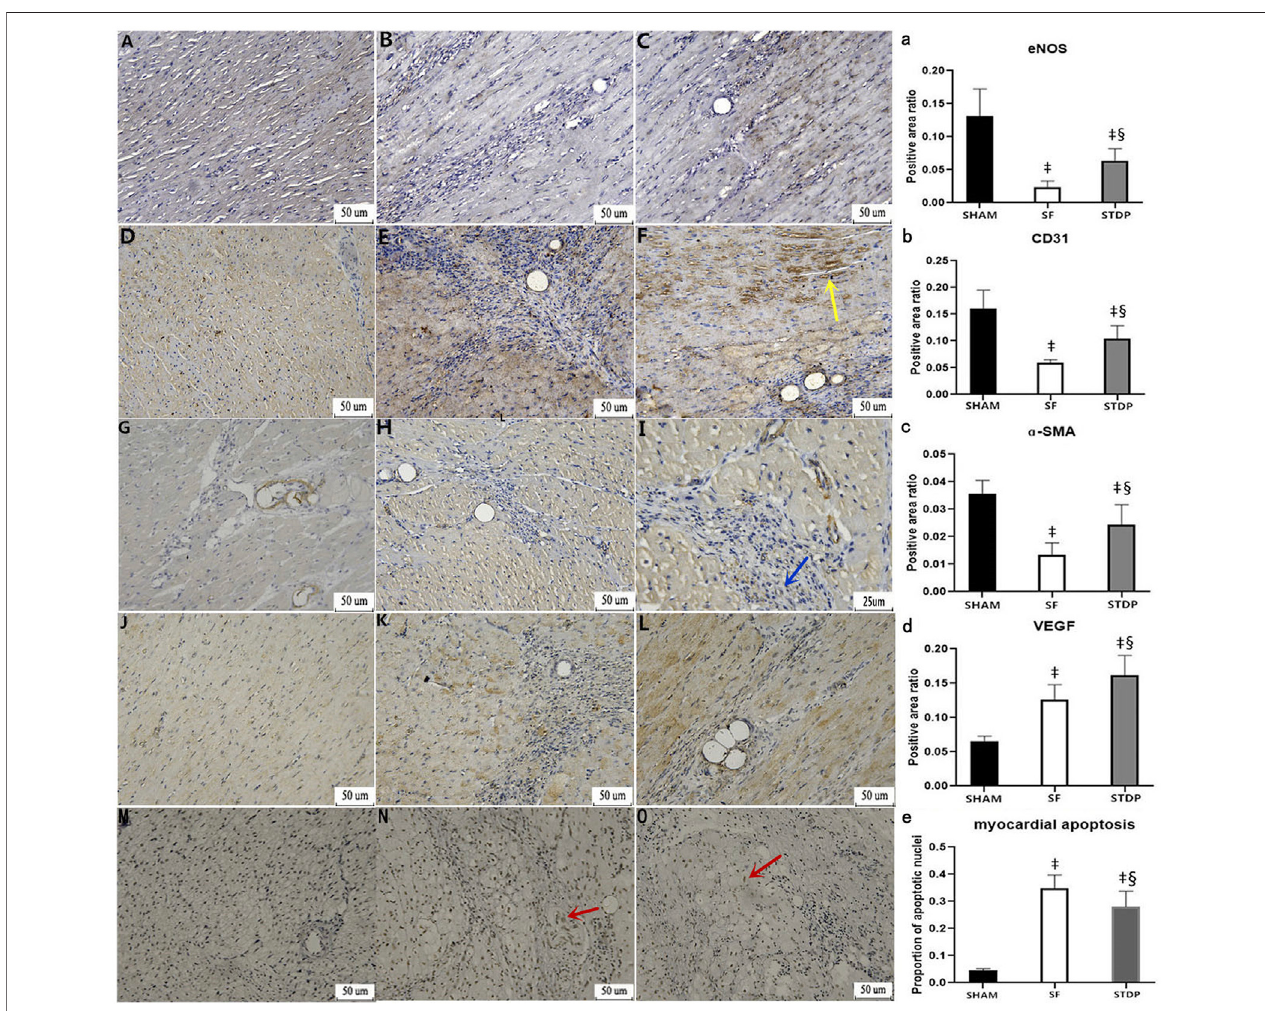
FIGURE 6 | Immunohistochemical analysis of myocardial specimens. (A – C) eNOS expression: (A) SHAM group × 200; (B) SF group × 200; (C) STDP group × 200 (D – F) CD31 expression: (D) SHAM group × 200; (E) SF group × 200; (F) STDP group × 200 (G – I) ɑ -SMA expression: (G) SF group × 200; (B) STDF group × 200; (C) STDPgroup×400 (J – L) VEGFexpression: (J) SHAMgroup×200; (K) SFgroup×200; (L) :STDPgroup×200 (M – O) Myocardialcellapoptosisstaining: (M) :SHAM group × 200; (N) : SF group × 200; (O) : STDP group × 200. Yellow arrow: in the STDP group, the microvascular hyperplasia expressing CD31 was active in the ischemia area. Blue arrow: increased expression of ɑ -SMA at microarteries was observed in the ischemia area of the STDP group. Red arrows indicated the apoptotic nucleus. Brownish yellow granules appear in myocardial nuclei around the microembolization area (indicating the onset of myocardial cell apoptosis). (a – e) : quanti fi ed and showed results in the bar graph below the fi gure. Data are presented as the mean ± SD. p < 0.05 ‡ vs. Sham group, and §vs. SF group ( n = 6 for each group).